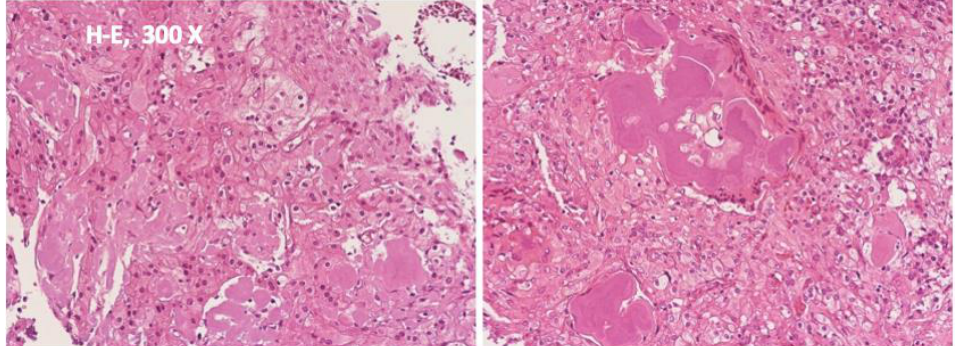
Figure 3. Examination of the surgical specimen showed polygonal epithelial cells with prominent intercellular bridges associated with amyloid and the presence of eosinophilic concretions forming annular structures (Liesegang’s rings) and calcifications. The margins of the surgical resection appeared to be tumor-free. No further treatment was recommended at this stage. Histopathological diagnosis indicated a calcifying epithelial odontogenic tumor (Pindborg tumor).